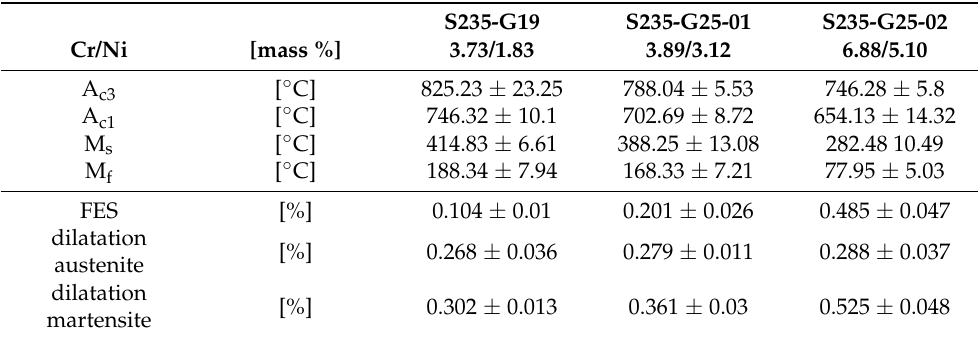
Figure 7. With increasing Cr and Ni content, the M s temperature drops. With the reduction in M s temperature, the strain during the martensitic phase transformation increases. This behavior was also observed in the austenitic phase transformation; however, the increase was not as pronounced. The final expansion strain (FES) describes the martensitic volume expansion from M s to room temperature. It is noticeable that the FES increases with higher alloy contents. The higher the FES, the higher the compressive stress introduction in the weld seam